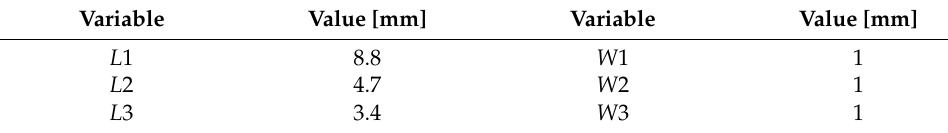
Table 4. The values of the physical dimensions of the E-CRLH